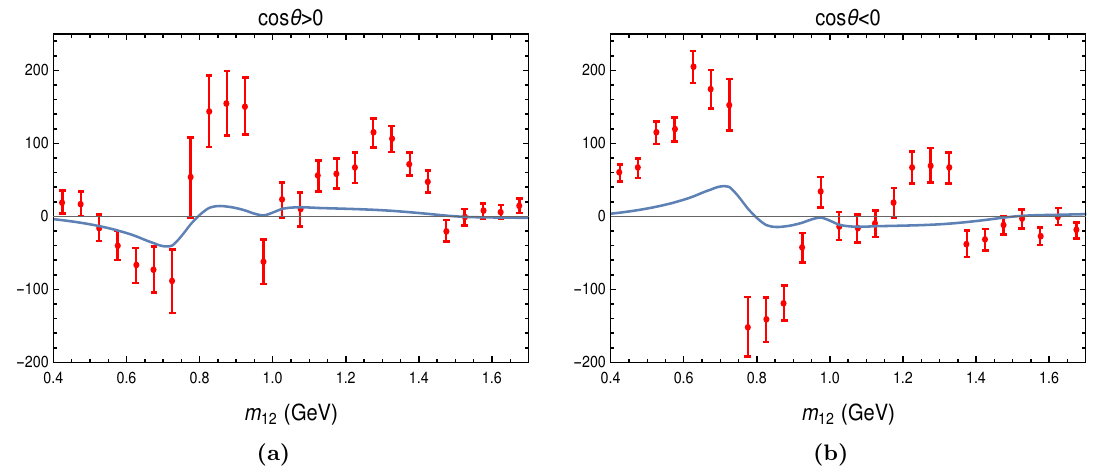
Figure 5. Di(cid:11)erence between the B (cid:0) and B + yield in our best (cid:12)t compared to the LHCb data [7]. that this region is also at the boundary of where the scalar form factor depicted in (cid:12)gure 2 can be trusted. Therefore, inelasticities may also play an important